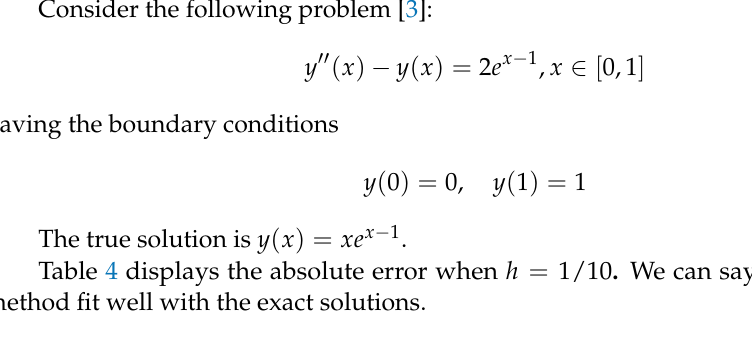
Table 4. Absolute errors for Problem 2 at h = 1/10.